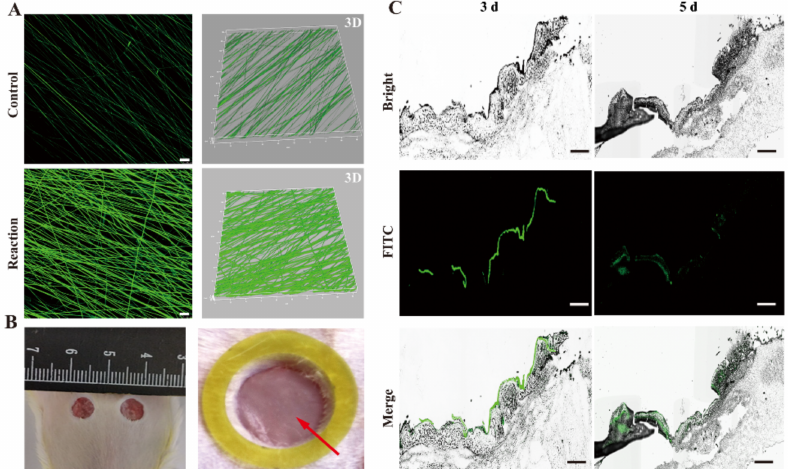
Figure 5. The degradation evaluation of scaffolds in vivo. ( A ) Representative confocal images (3D images at right side) of FITC labeled scaffolds. Control: physically absorbed FITC. Reaction: cross- linked FITC. Scale bar = 10 µ m. ( B ) The implantation process of scaffolds. Red arrow: scaffold. ( C ) The biodegradability evaluation of scaffolds in vivo. Scale bar = 250 µ